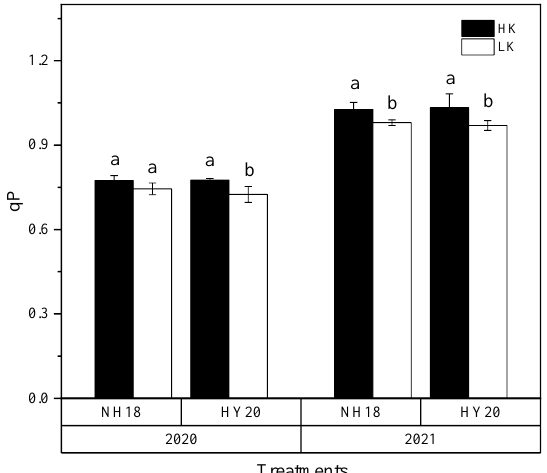
Figure 9. Effect of low K stress on photochemical quenching coefficient. HK: high K treatment; LK: low K treatment. For the bar chart, a,b indicates a significant difference between different treatments for the same variety( p < 0.05).